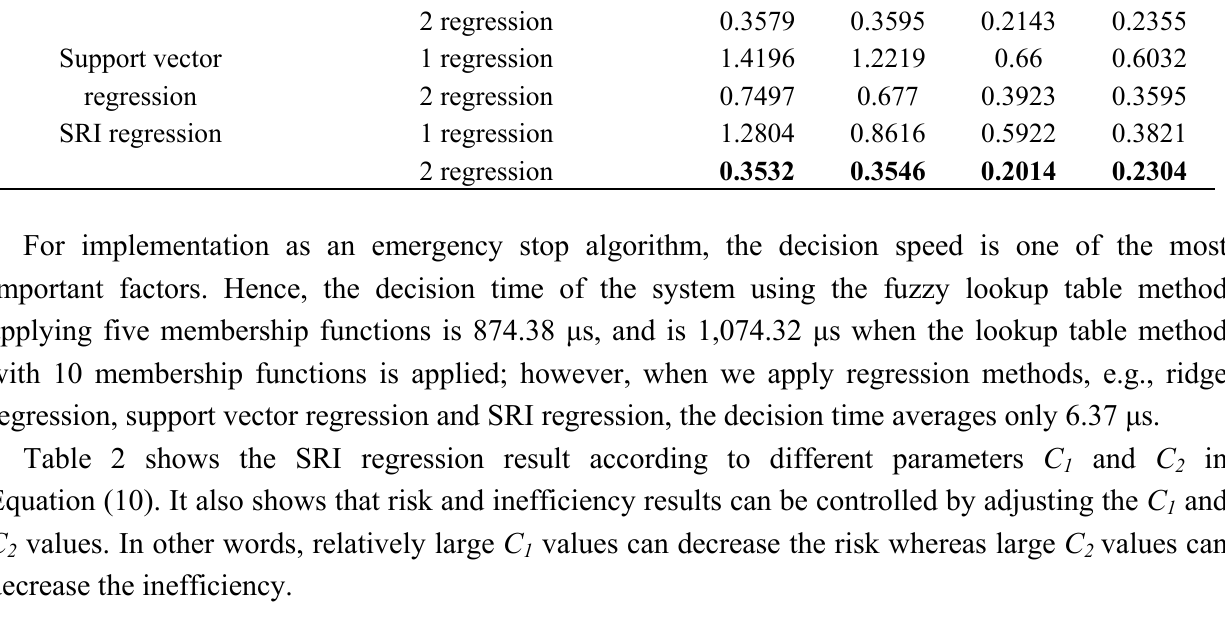
Table 2. SRI regression results according to different C